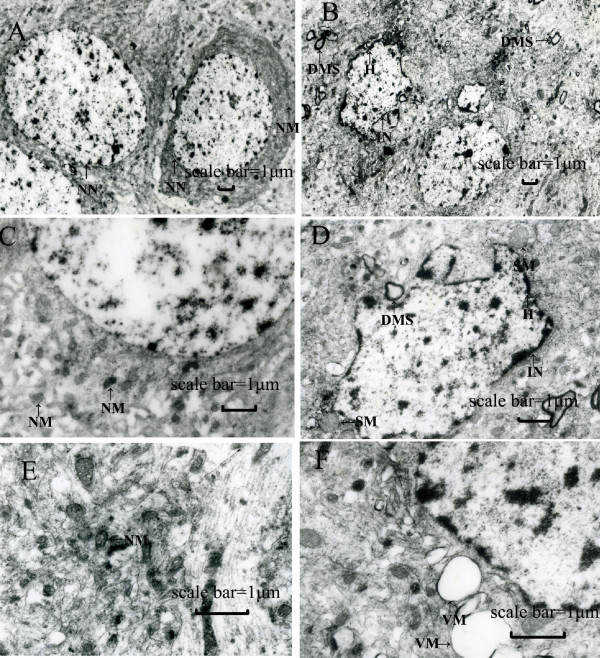
Representative electron micrographs of coronal sections of the rat hippocampus are shown. (A, C, and E) control hippocampus. (B, D and F) lead-exposed hippocampus in rats at weaning that were treated with 0.2% lead acetate during the gestational and lactational periods as described. Abnormal appearance of neurons including irregular shaped nucleus, swollen mitochondria, often vacuolated with disrupted cristae, a large quantity of heterochromatin collected inside the nucleus, demyelination or shrinkage, and denaturation of the myelin sheath were observed. These findings suggest that hippocampal ultrastructures were injured by lead exposure during the early stage of life. Scale bar = 1 μm. NN: normal nucleus; IN: irregular nucleus; SM: swollen mitochondria; VM: vacuolated mitochondria; NM: normal mitochondria; H: heterochromatin; DMS: denaturation of myelin sheath.